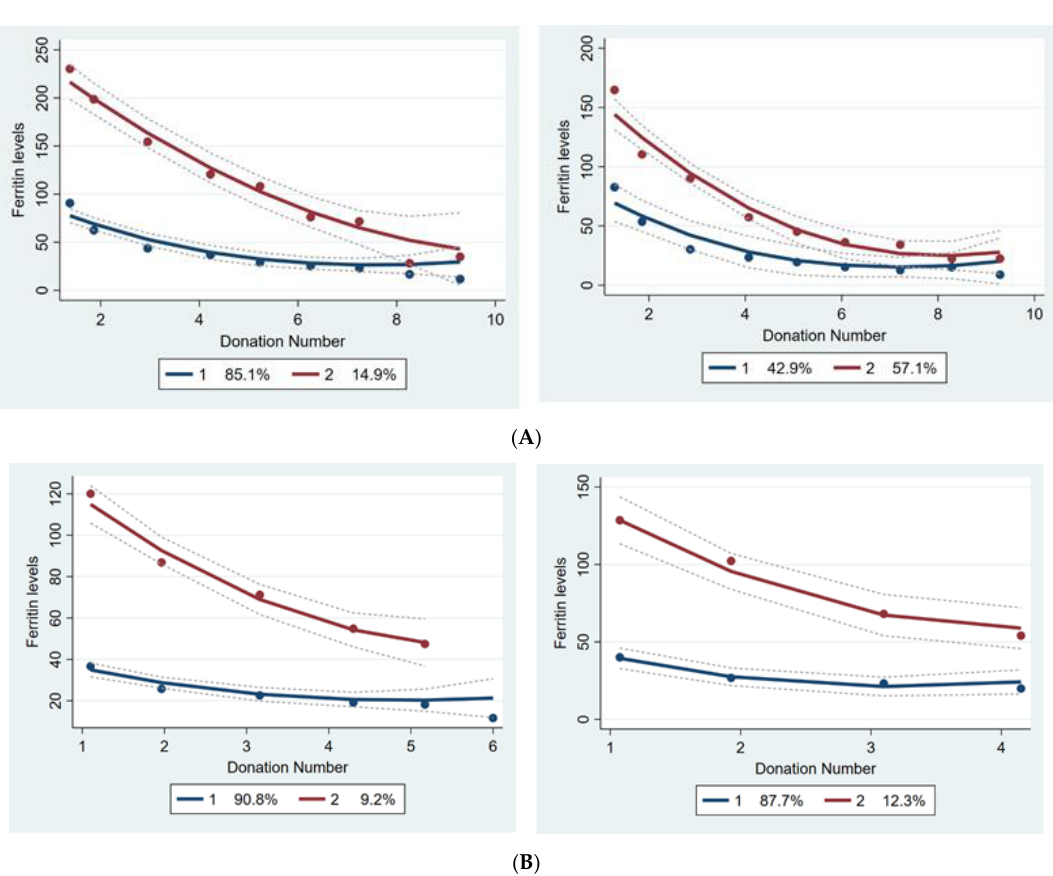
Figure 2. ( A ) Group-based trajectory analyses exhibit changes in ferritin levels by donation number in each latent class for male donors in unadjusted models (left) and models adjusted for time since the previous donation (right) in the FIND+ study September 2017 – September 2019. Blue line (line No. 1) refers to class 1. Red line (line No. 2) refers to class 2. ( B ) Group-based trajectory analyses exhibiting changes in ferritin levels by donation number in each of the latent classes for female donors in unadjusted models (left) and models adjusted for time since the previous donation (right) in the FIND+ study, September 2017-September 2019. Dotted line represents the confidence interval for the levels of ferritin over donation times. Blue line (line No.1) refers to class 1. Red line (line No.2) refers to class